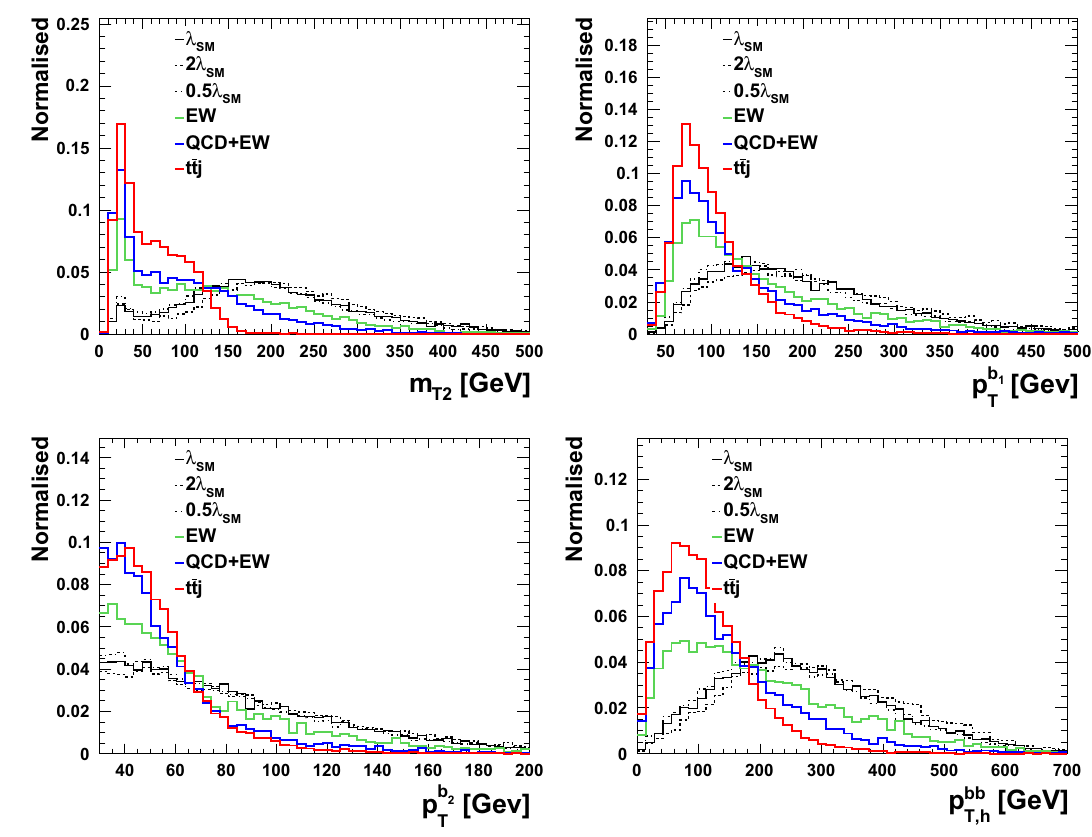
Fig. 2 Normalised differential distributions that serve to isolate signal from background in the τ (cid:3) τ h case in the BDT